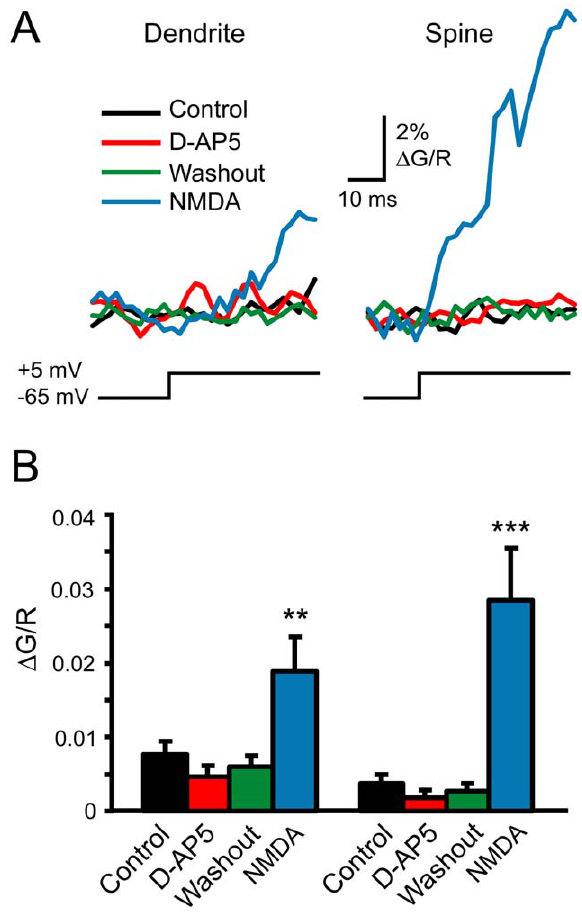
Figure 2. Ambient glutamate concentrations are too low to generate significant Ca 2 + influx through NMDARs in dendrites or spines. A. Averaged Ca 2 + transients (500 Hz line scans) evoked by 40 ms voltage step in a dendrite (left) and spine (right) in control (black), D-AP5 (red, 10 m M), after a 10 min washout of D-AP5 (green), and in 5 m M NMDA (blue). Mibefradil (20 m M), nimodipine (20 m M) and TTX (0.5 m M) were present throughout. B. Comparison of Ca 2 + transient amplitudes in each condition (n=11). Error bars indicate standard error of the mean (SEM). Significance determined by Friedman ANOVA with Conover posthoc test: **p , 0.01; ***p , 0.001.